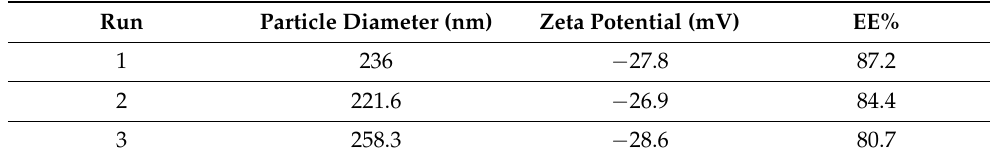
Table 4. Particle size, zeta potential and EE% of different